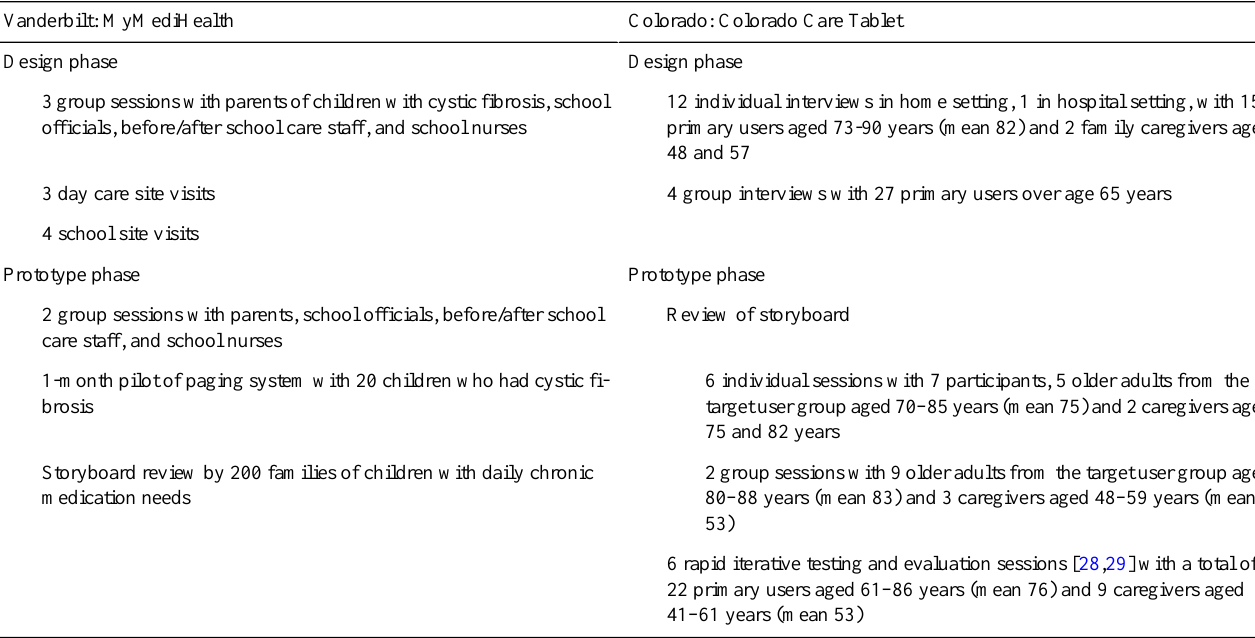
Table 1. Users and settings studied in user-centered design